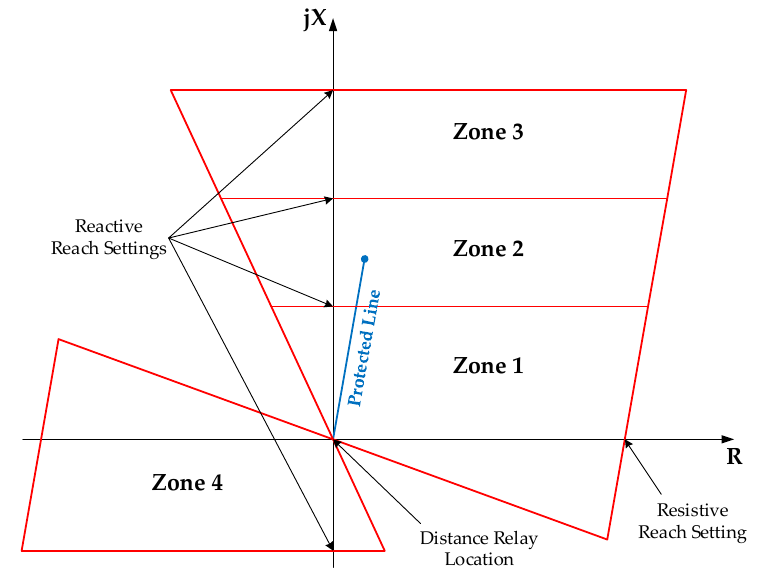
Figure 1. Typical quadrilateral operation characteristic for distance protection.